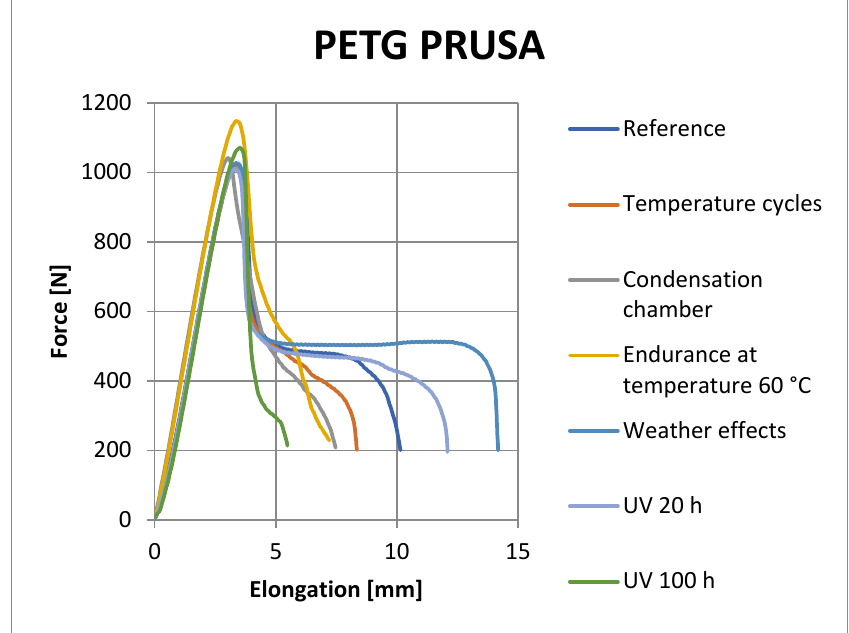
Figure 9. Tensile curves of PETG Prusament samples.